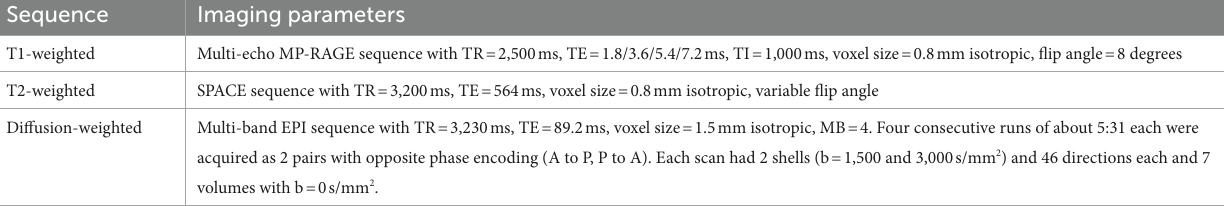
TABLE 2 MRI acquisition